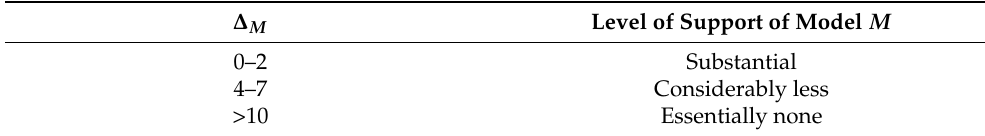
Table 1. Rule of thumb for AIC differences. ∆